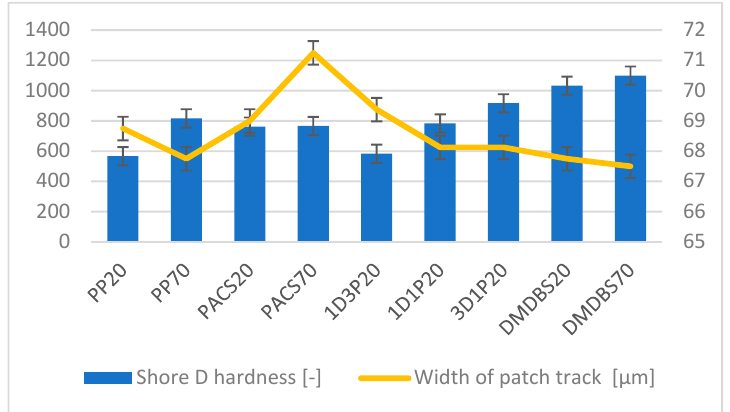
Figure 8. Comparison between hardness of the samples and the width of the patch track.